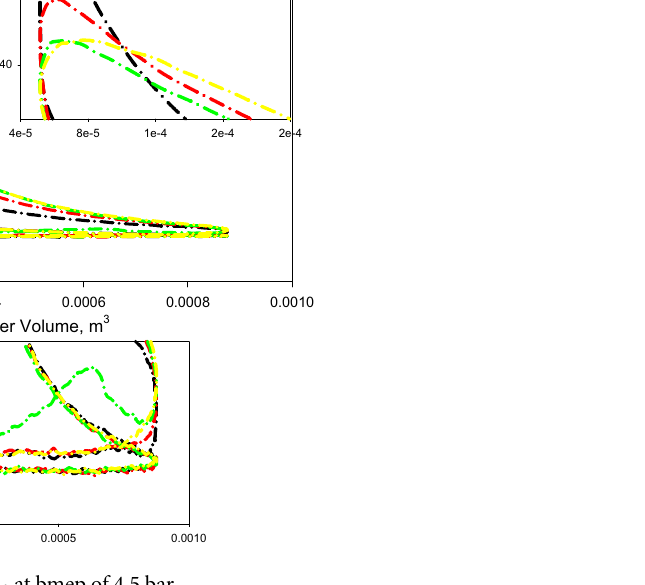
Figure 7. Change of P cyl. vis V cyl. at bmep of 4.5